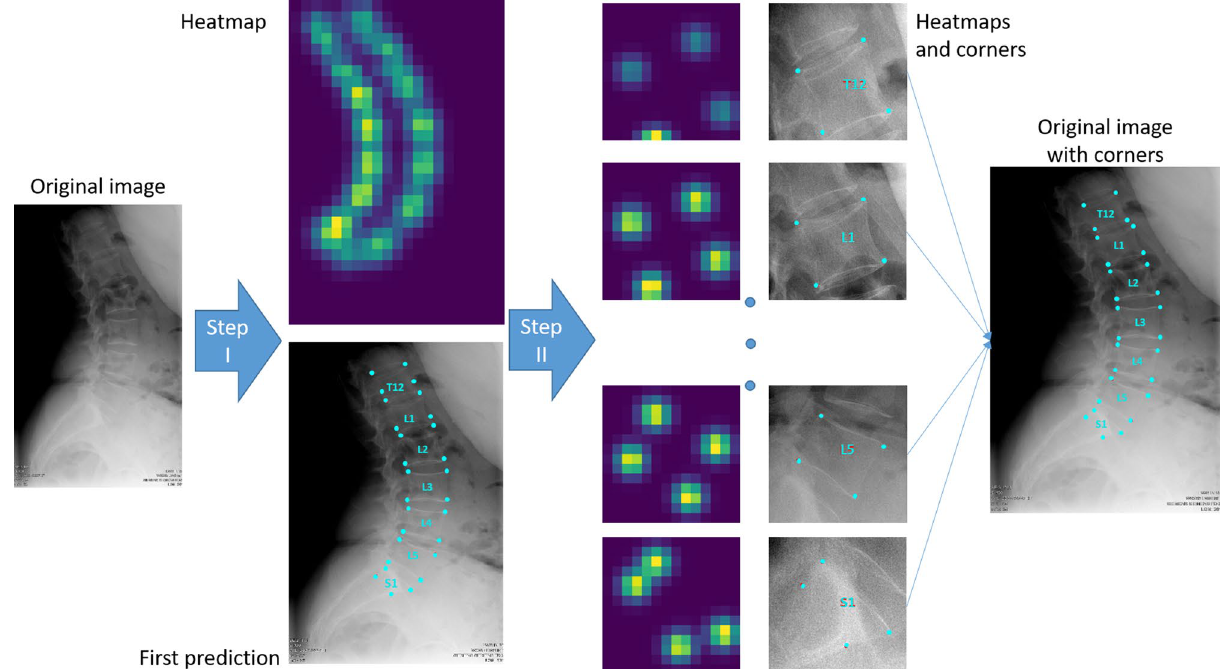
Figure 1. Predictions of the 2-step model for a representative image. The image from the test set is input into the model and processed to obtain an image fully annotated with the corners and names of the vertebrae. The heatmaps were generated using the Matplotlib library (https:// matpl otlib. org/) in Python 3.8 (https:// www. python. org/ downl oads/ relea se/ python-